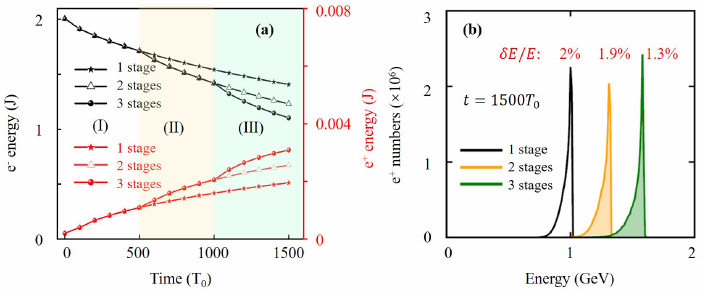
Figure 8. ( a ) Time variation of total electron energy and total positron energy, ( b ) positron energy spectrum at t = 1500 T 0 after one, two and three acceleration